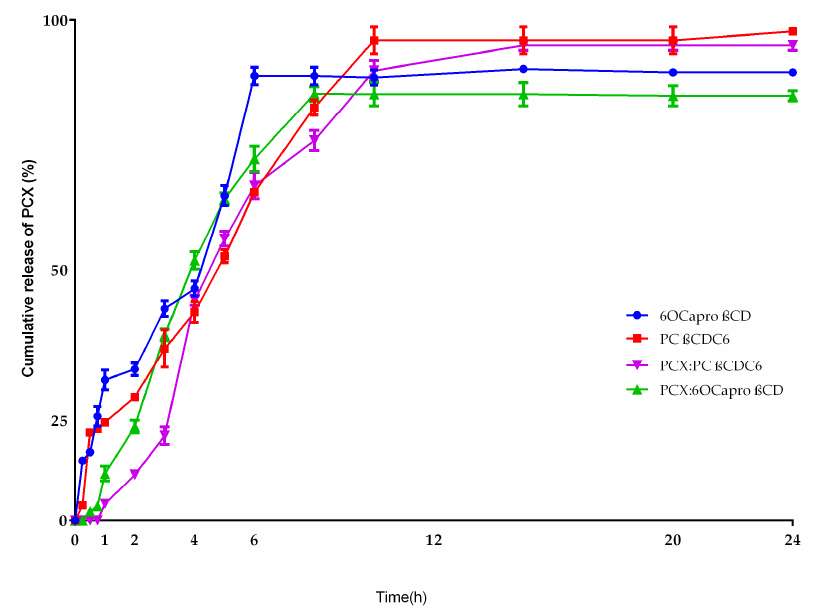
Figure 6. Release profile of PCX from amphiphilic nanoparticles and PCX:CD inclusion complex ( n = 3, ±SD).